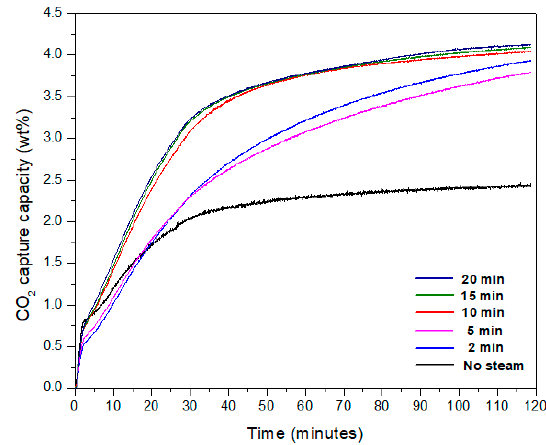
Figure 1. TGA data for electrospun samples before steam exposure (no-steam) and after steam exposure for different time periods (2-min, 5-min, 10-min, 15-min, and 20-min).